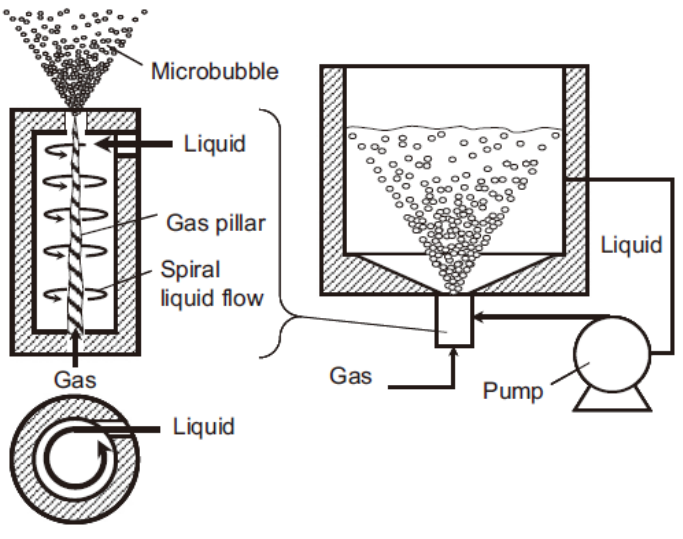
Figure 1. Spiral liquid flow generation